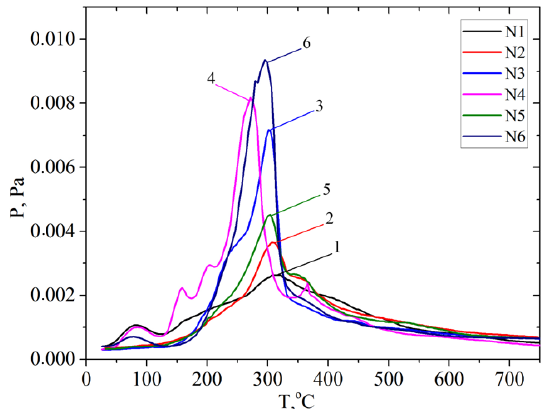
Figure 6. P/T curves of vapor pressure of gaseous products measured at temperature of pyrolysis: solids after hydrolysis of materials based on apricot seed shells (N1–3) and walnut shells (N4–6): 1 and 4—solid after alkaline pretreatment; 2 and 5—solid after acid pretreatment; 3 and 6—solid after pretreatment with steam explosion.